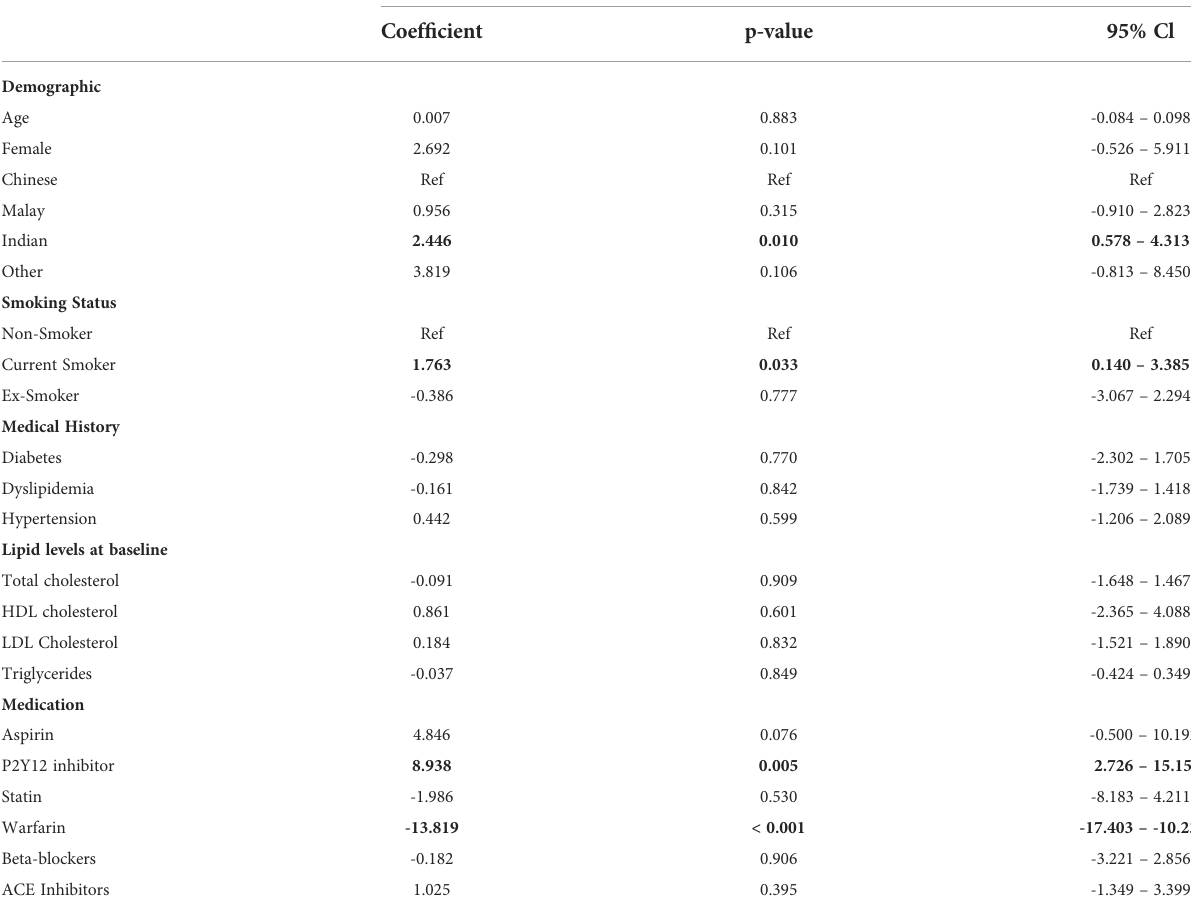
TABLE 2 ML-SEM modeling for plasma TF activity in post-AMI